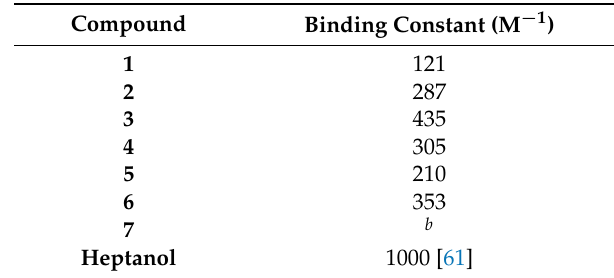
Table 2. Literature-reported binding constants of analytes 1 – 7 with β -cyclodextrin a .